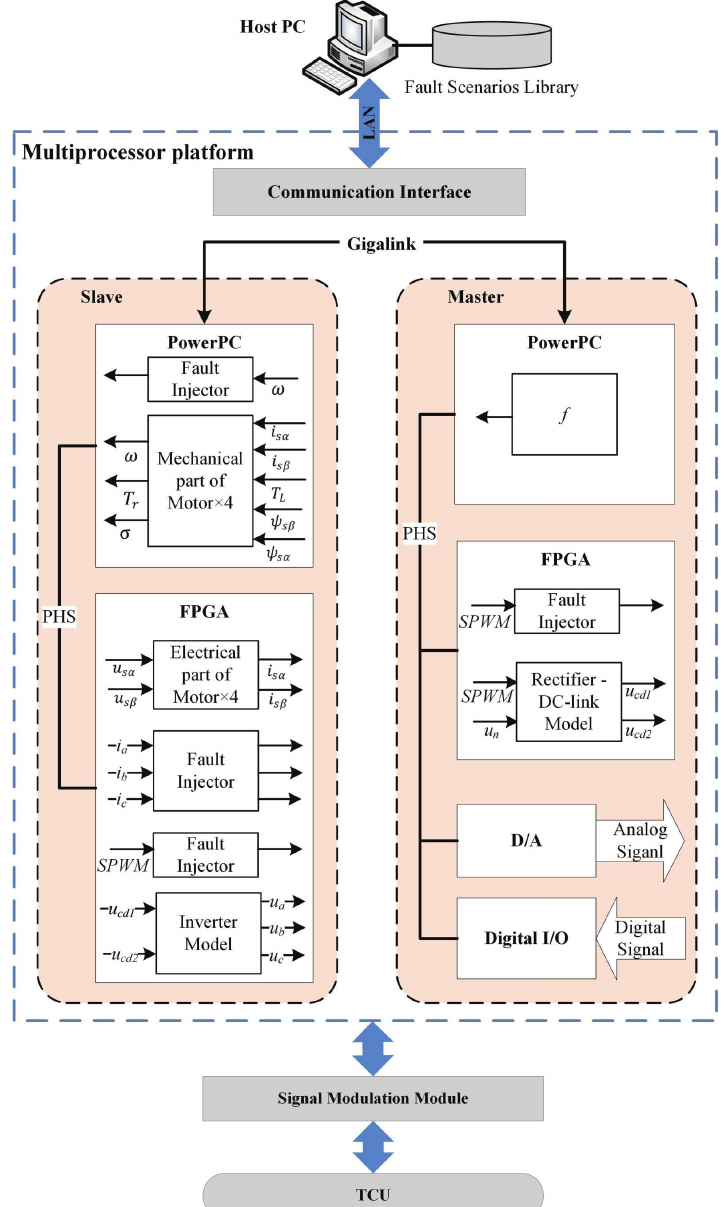
Figure 3. Schematic views of multi-FPGAs/CPUs HIL platform for real-time fault